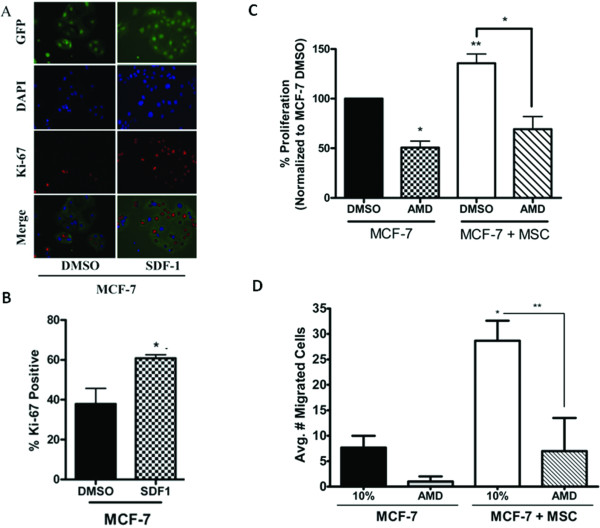
Inhibition of CXCR4 signaling decreases hMSC stimulated MCF-7 proliferation and migration in vitro. (A) MCF-7 cells cultured alone were treated with DMSO (control) or SDF-1 (50 ng/ml) for 72 hours. Cells were fixed and stained with anti-Ki-67 (red) and nuclei were counter stained with DAPI (blue). Representative images of MCF-7 cells at 200×. (B) Quantification of cells positive for Ki-67 staining from 10 fields of view per treatment. Data is represented as percent positive cells of total cells counted. Bars represent mean values ± SEM. (C) MCF-7 cells were seeded in the lower chamber of a 24-well plate and a transwell insert was placed in each well. MCF-7 cells or hMSCs were seeded in the upper well. Upper and lower chambers were treated with DMSO (control) or AMD3100 (5 μg/ml). After 7 days of culture, inserts were removed and MTT was added to each well. After 4 hours cells were lysed and absorbance read. All data are represented as mean percent proliferation as compared to MCF-7 + DMSO (control) treated cells ± SEM. (D) MCF-7-GFP cells alone or in combination with hMSCs (1:1) were seeded in the upper chamber of a transwell system where the lower wells contained culture media supplemented with 10% FBS (10%). Upper and lower chambers were treated with DMSO (control) or AMD3100 (5 μg/ml). After 48 hours cells were fixed and the number of GFP-positive migrated cells counted. Bars represent average number of migrated cell per condition ± SEM, (*, p < 0.05; **, p < 0.01).